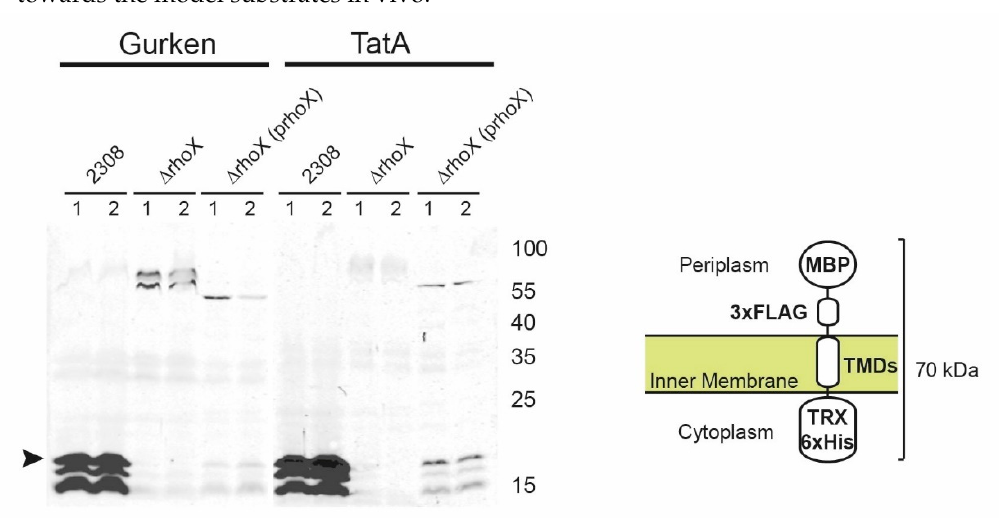
Figure 4. B. abortus rhomboid activity in vivo. Cleavage of Gurken and TatA chimeric substrates expressed by the indicated B. abortus strains (2308: wild type; ∆ rhoX : rhomboid deletion mutant; ∆ rhoX + p rhoX : rhomboid deletion mutant complemented with wild type rhomboid). Total protein extracts were analyzed by SDS-PAGE and Western blot with anti-His antibody (in duplicates). The bands corresponding to processed substrates are pointed out by an arrowhead. A schematic representation of the chimeric protein substrates is shown on the right.